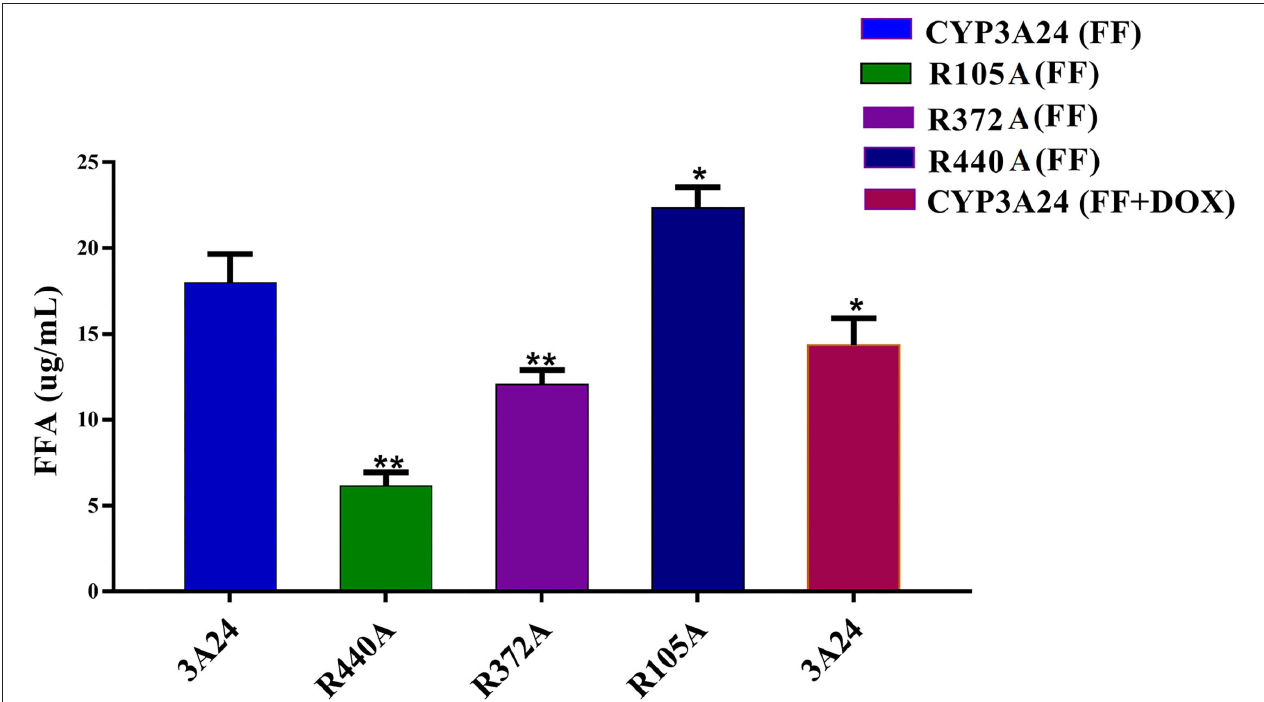
FIGURE 6 | Incubation of CYP3A24 with FF and DOX and its mutants (R105A, R372A, and R440A). The vertical axis represents FFA production. The data were expressed as mean ± standard deviation (error bars) ( n = 3). **( P < 0.01) and *( P < 0.05) indicate statistically significant difference between the CYP3A24 and each